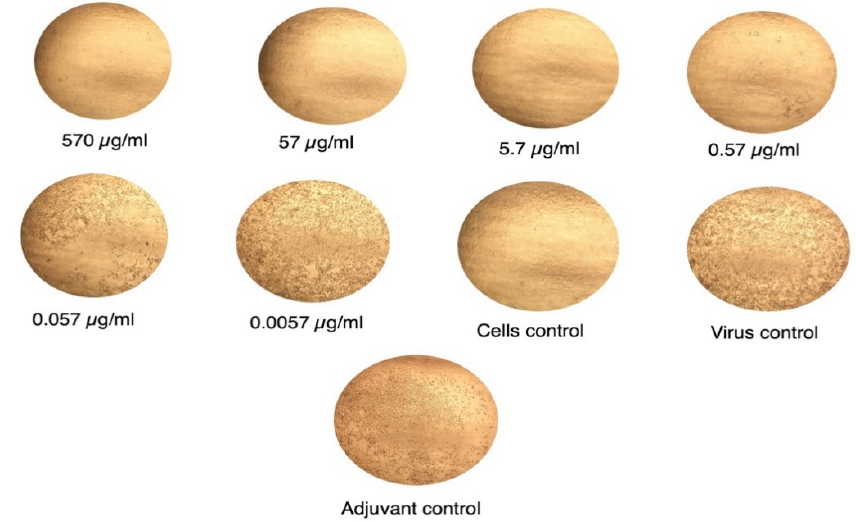
Figure 6. Examples of different concentrations of anti-S1 IgY antibodies tested against MERS-CoV on Vero-E6 cells examined by CPE. The IC100 neutralization of the antibody were determined as the reciprocal of the highest dilution at which no CPE was observed.